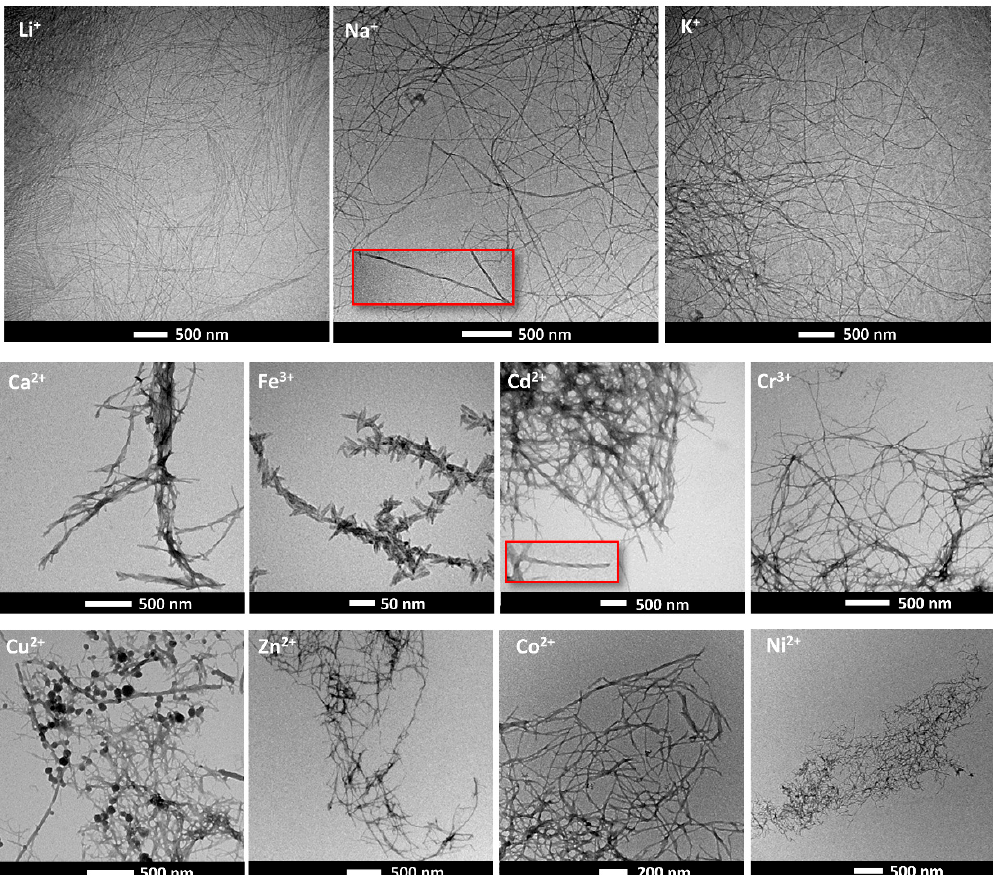
Figure 4. Transmission electron microscopy (TEM) images of the cation induced metallogels. Images were recorded in dry samples without the use of stain.